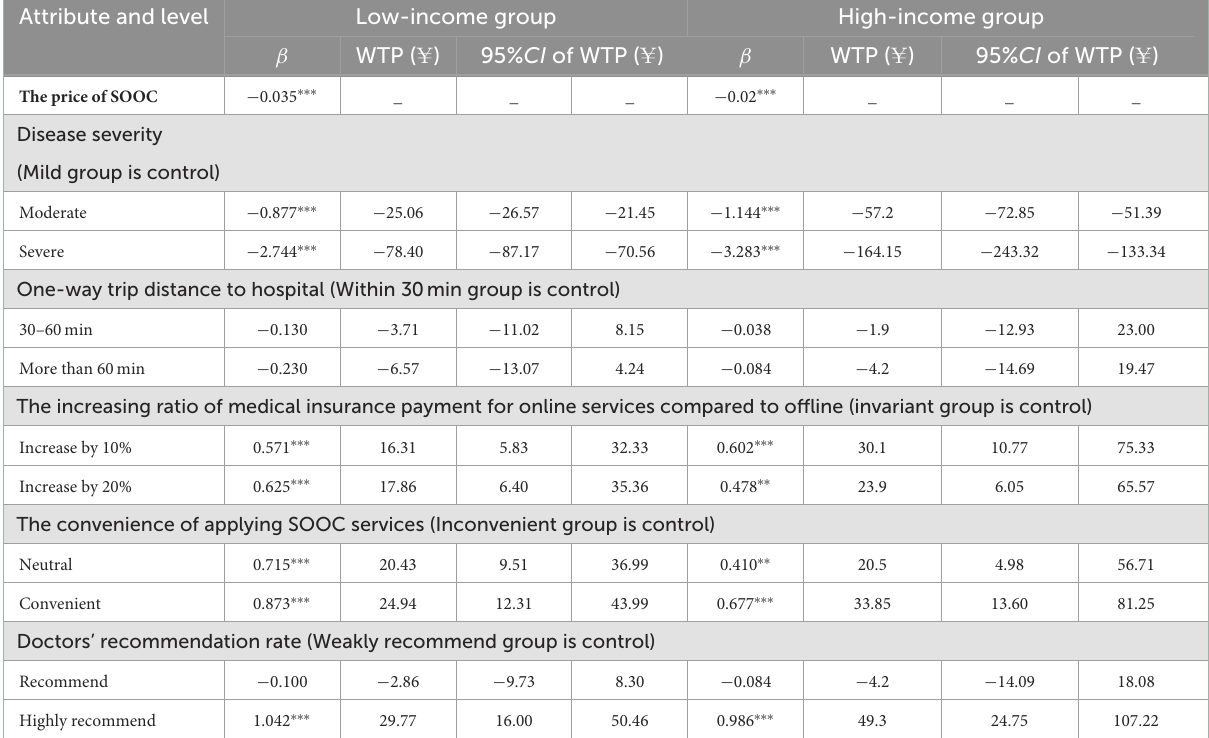
TABLE 8 Conditional logit regression analysis and the WTP of patients with different income conditions. Attribute and